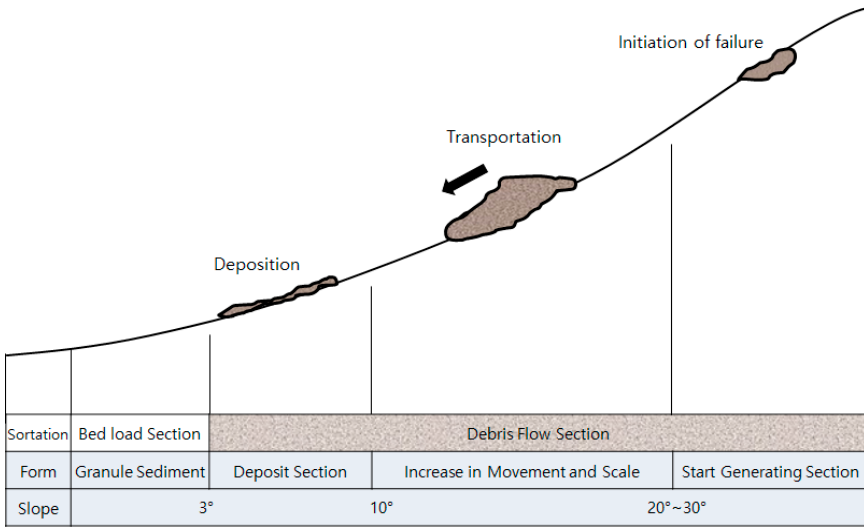
Figure 2. Initiation, transportation, and deposition of debris flows [25].